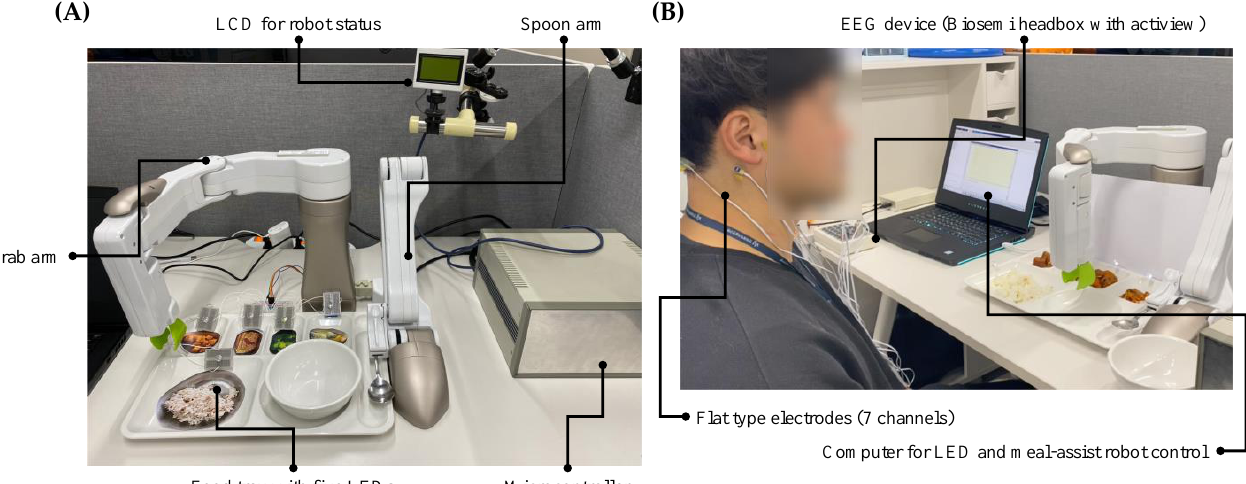
Figure 4. Devices for real-time system. ( A ) Components of meal-assist robot and related parts. ( B ) Devices for EEG acqui- sition.